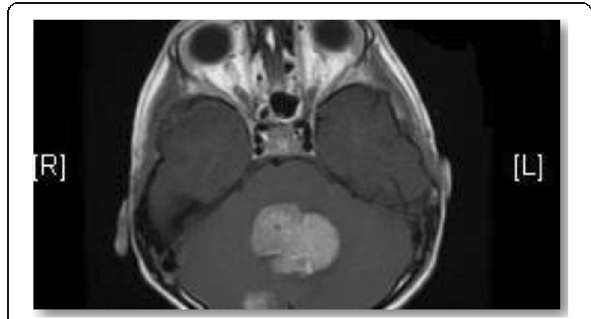
Fig. 1 Brain MRI revealed a posterior fossa tumor with obstructive hydrocephalus